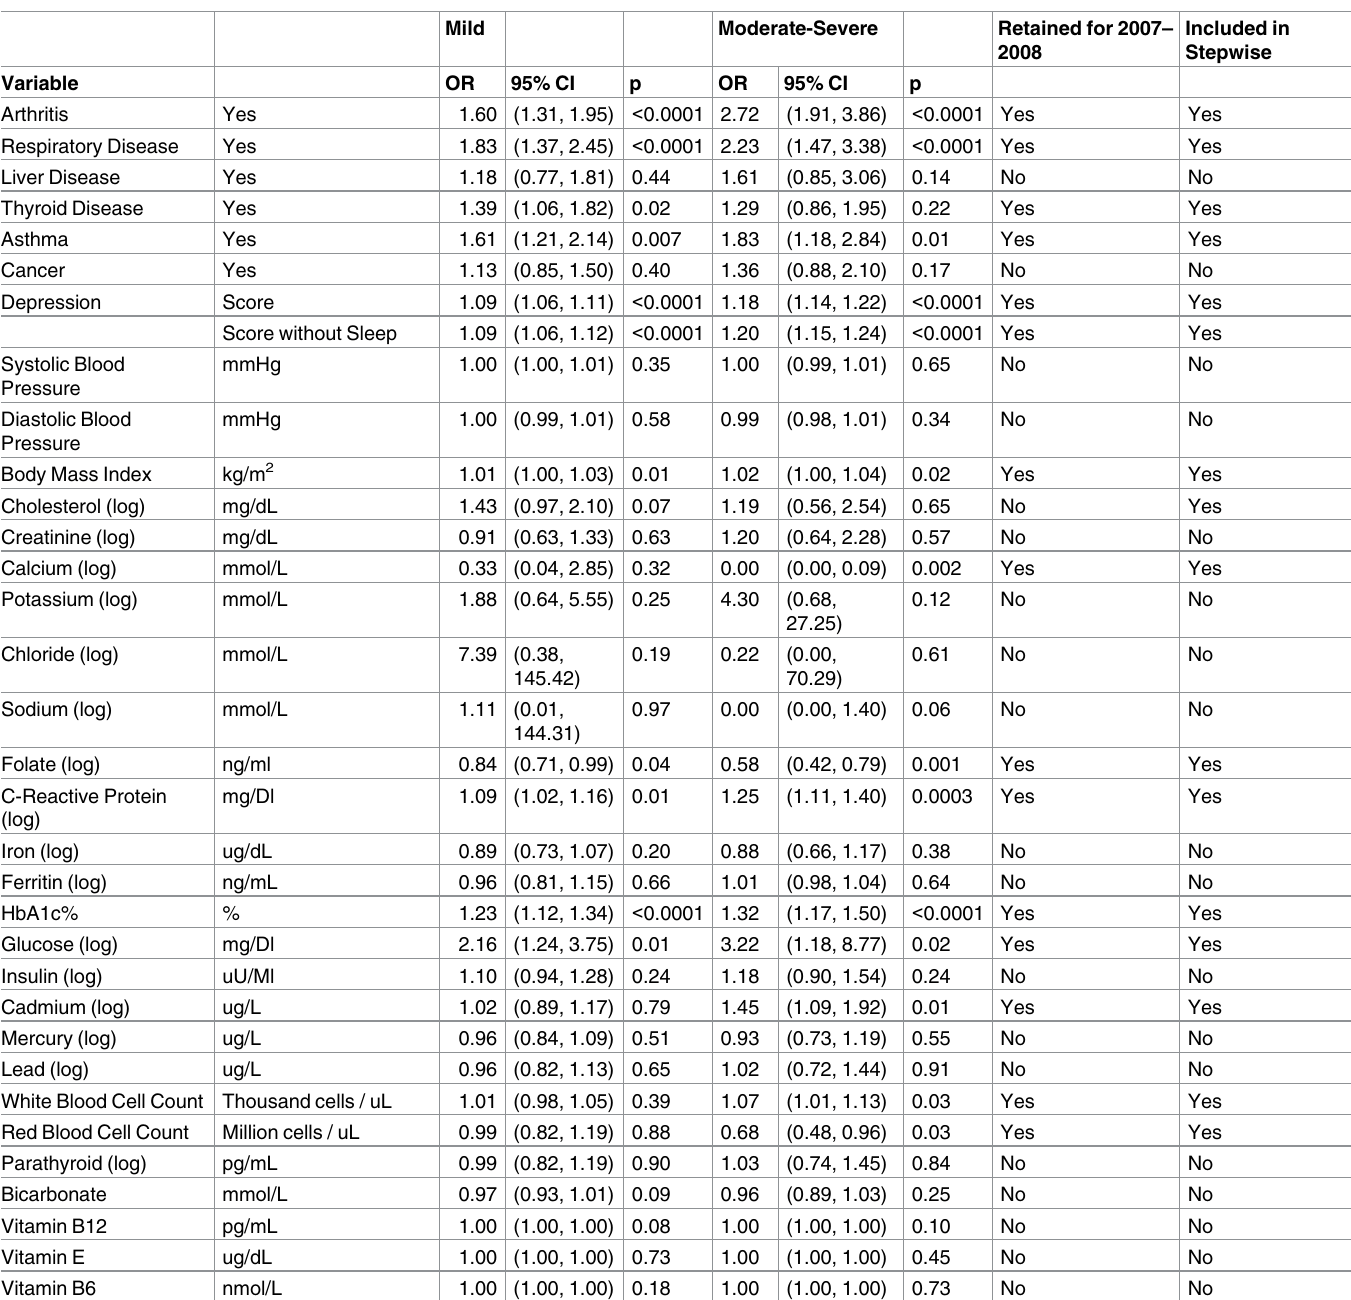
non-restorative sleep (positive relationship), red blood cell count (negative relationship), edu- cation (positive relationship for only those with some college), angina (negative relationship with moderate-severe leg cramps), and difficulty maintaining sleep (positive relationship only for mild